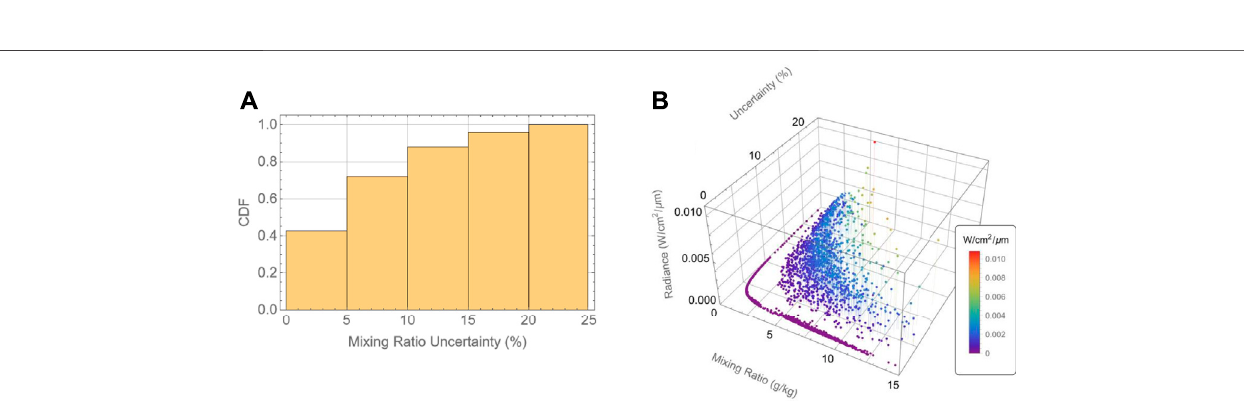
FIGURE 6 | (A) Cumulative Distribution Function for the PBL water vapor mixing ratio simulations. (B) water vapor mixing ratio uncertainty as a function of background radiance.